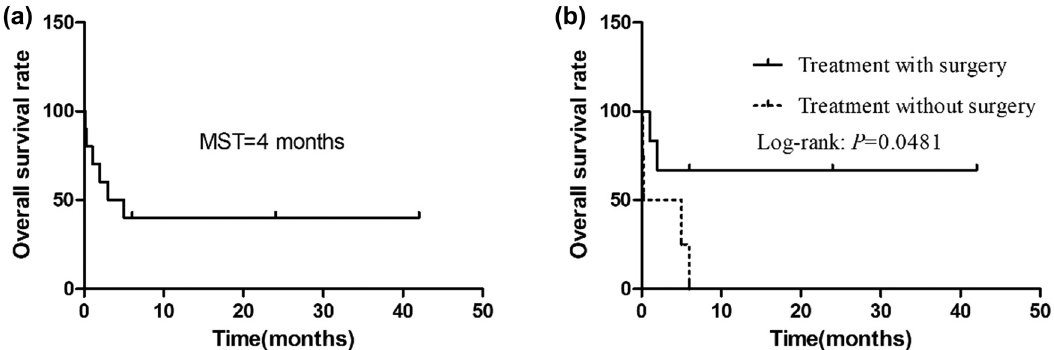
Figure 5: Kaplan – Meier OS. ( a ) OS in all cases. ( b ) OS by treatment. MST, median survival